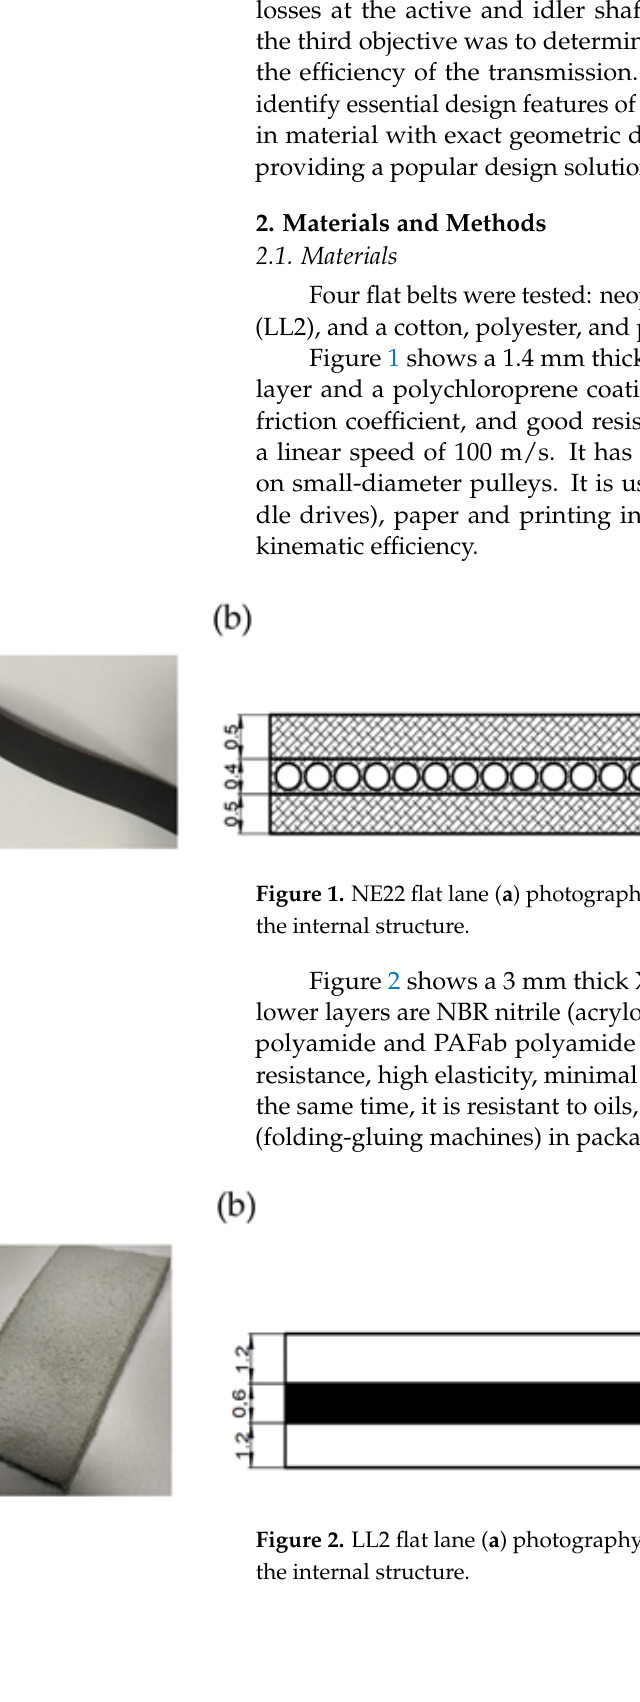
Figure 3. XH 500 flat lane ( a ) photography, ( b ) belt cross section, ( c ) optical light microscopy images of the internal structure.